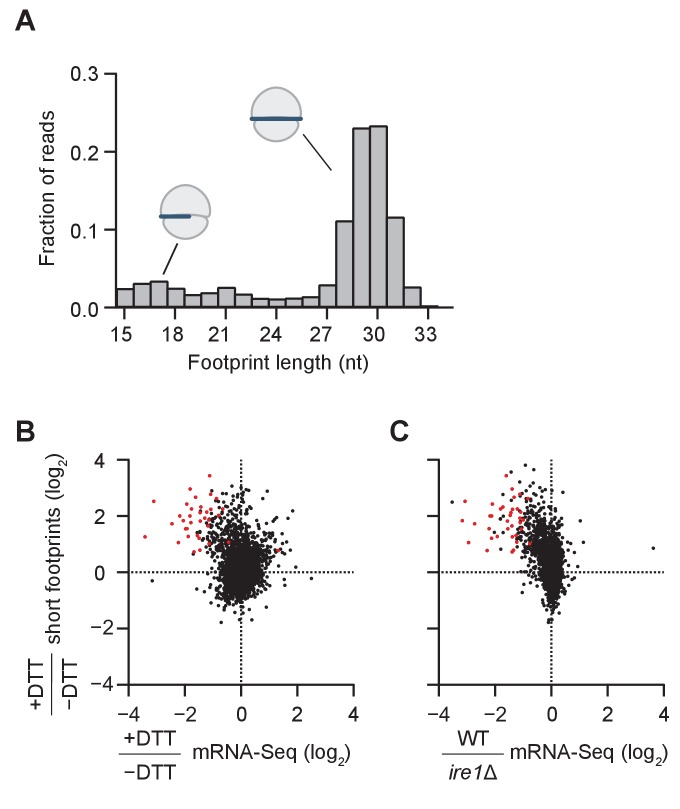
Short ribosome footprints are enriched on RIDD targets.(A) Size distribution of ribosome footprints mapped without mismatches to the transcriptome for dom34Δ/ski2Δ in the presence of DTT. Short footprints on truncated mRNAs correspond to 15–18 nt reads (Guydosh and Green, 2014) and ribosomes with a fully-occupied mRNA channel correspond to 28–31 nt (Ingolia et al., 2009). The small peak at 21 nt corresponds to ribosomes in an alternate conformation (Lareau et al., 2014). (B) Comparison of gene enrichment ratio (+DTT/−DTT) for 15–18 nt footprint data in the dom34Δ/ski2Δ background (y-axis) and mRNA-Seq data (x-axis) under the same growth conditions in the WT background. (C) Comparison of the same short footprint data ratio (y-axis) against mRNA-Seq data (x-axis) for WT/ire1Δ under UPR induction. Annotation of 39 previously-identified RIDD mRNA targets (red dots in B and C) and WT/ire1Δ mRNA-Seq ratios (C) are from (Kimmig et al., 2012). Anti-correlated trends in B and C show that mRNAs degraded by RIDD (low mRNA-Seq ratios when DTT added or ire1 deleted) are enriched in stalled ribosomes (footprints), consistent with the prediction that cleavage sites created by Ire1 stall ribosomes on short (15–18 nt) footprints.